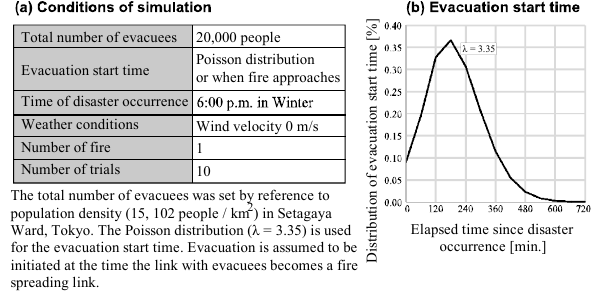
Figure 8. Conditions of